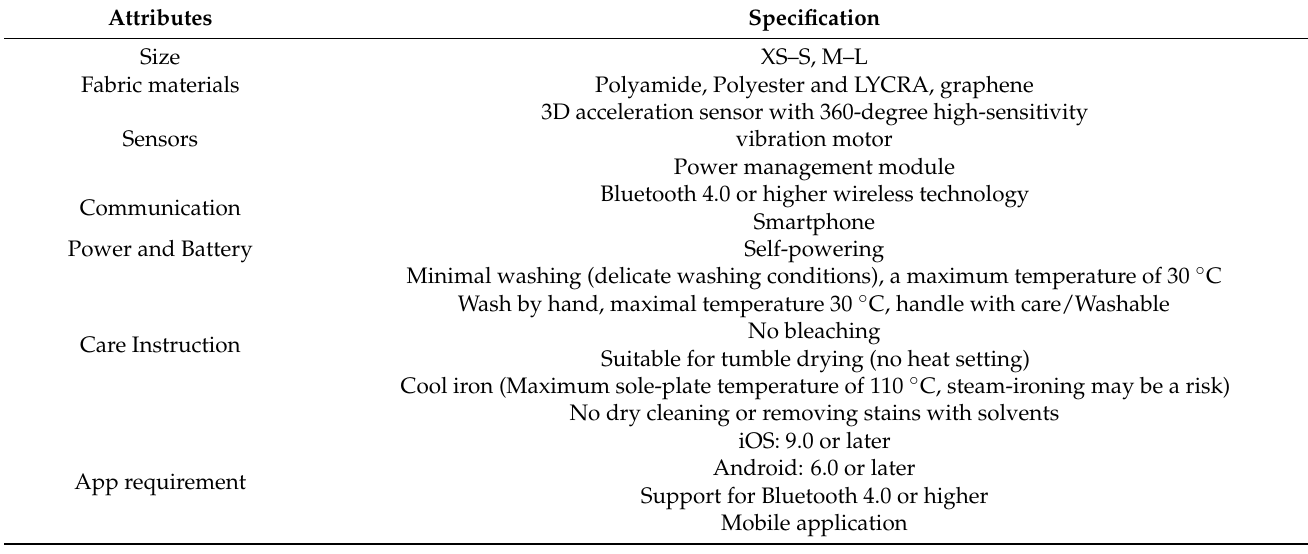
Table 2. Conceptual technical specification for future smart leggings (adapted from [80]).